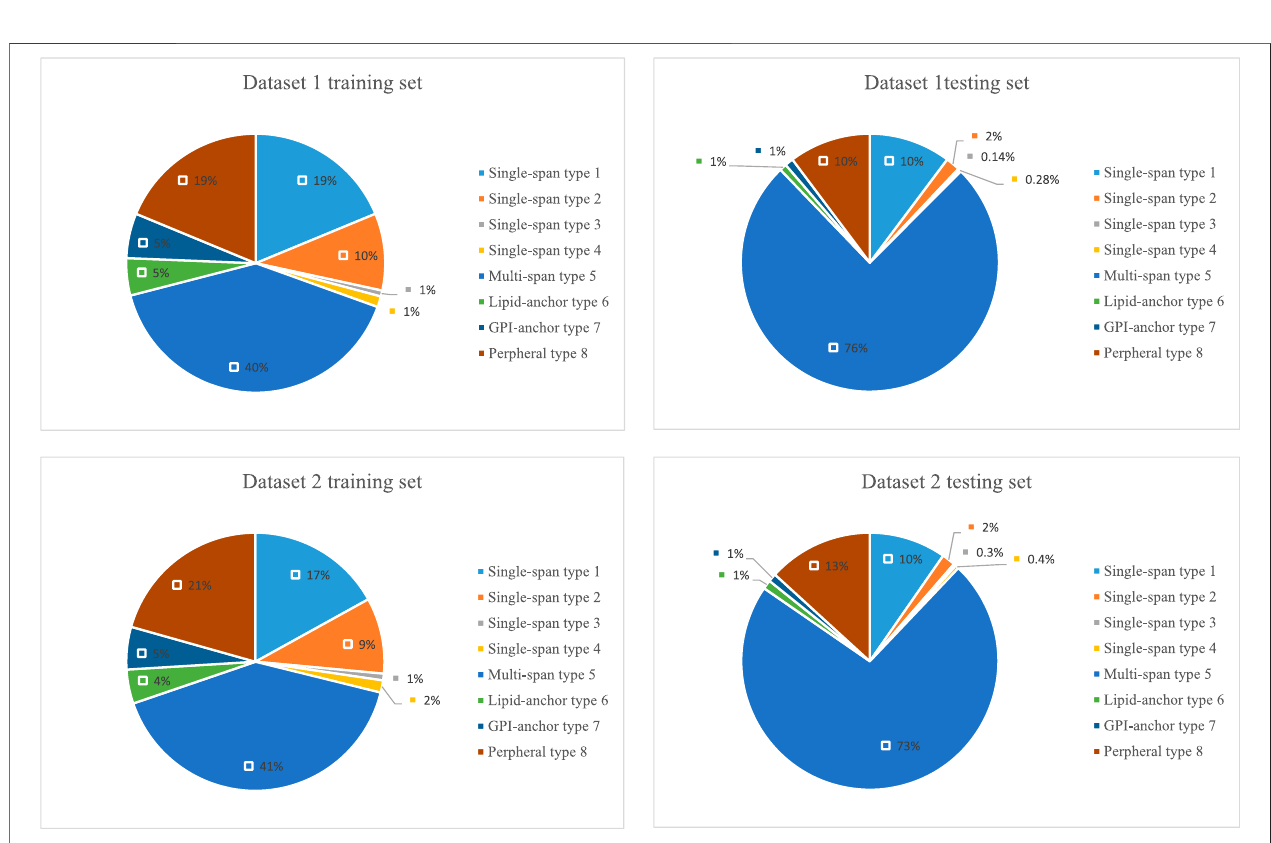
FIGURE 6 | Distribution of the lengths of the training and test sets in the two